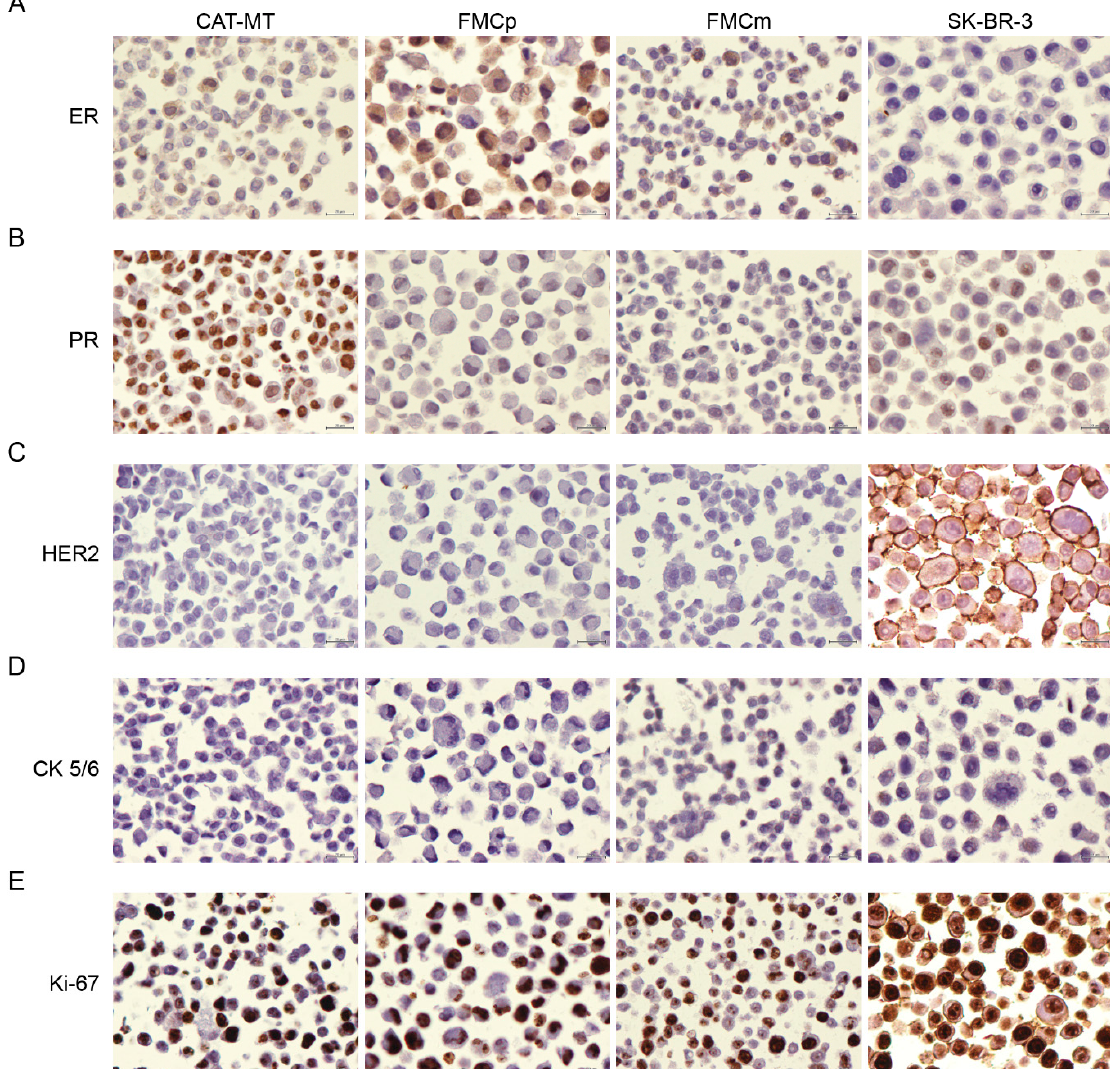
Figure 1. Molecular subtypes of feline mammary carcinoma cell lines. The feline cell lines (CAT-MT, FMCp, and FMCm) and the human breast cancer cell line SK-BR-3 were evaluated by immunocytochemistry for ( A ) ER, ( B ) PR, ( C ) HER2, ( D ) CK 5/6, and ( E ) proliferation index (Ki-67). CAT-MT shows weak (5%) staining for ER, strong (70%) staining for PR, negative staining for HER2, negative staining for CK 5/6, and strong (~50%) staining for Ki-67. FMCp shows strong (~70%) staining for ER, negative staining for PR, HER2, and CK 5/6, and strong (~60%) staining for Ki-67. FMCm shows weak (10%) staining for ER, negative staining for PR, HER2, and CK 5/6, and strong (~70%) staining for Ki-67. SK-BR-3 shows negative staining for ER, average (3%) staining for PR, intense staining for HER2, negative staining for CK 5/6, and strong (~50%) staining for Ki-67. Original magnification ×400 (Mayer's hematoxylin).